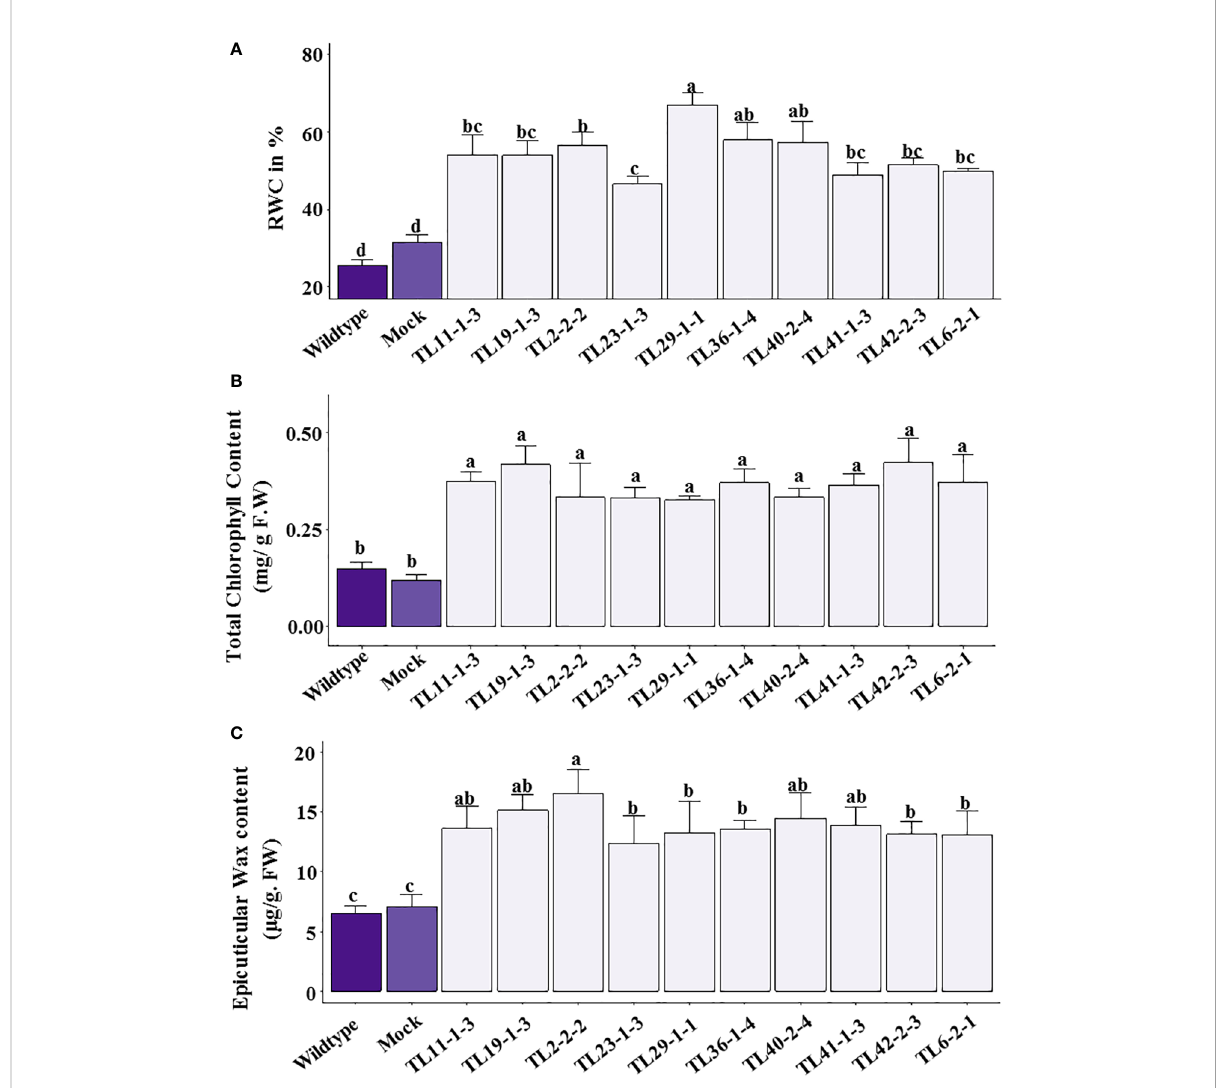
FIGURE 7 Physiological parameters in multigene transgenics lines, wild type and mock plants under drought stress: (A) Relative water content (% RWC), (B) Total chlorophyll content, (C) Epicuticular wax content. The values are mean of 3 biological replicates (n=3) and error bars denotes standard error. The alphabets on the error bars indicate signi fi cant variation ( p ≤ 0.05) between transgenic lines, wild type and mock